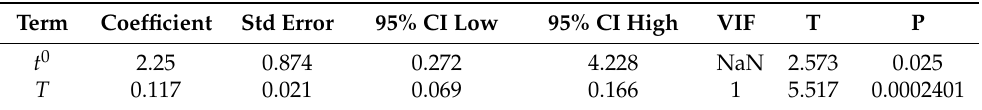
Table 2. Results of statistical analysis, for the interpolation (using first-degree polynomial) of lettuce mass variation over time, grown in soil with 4.5% zinc concentration.